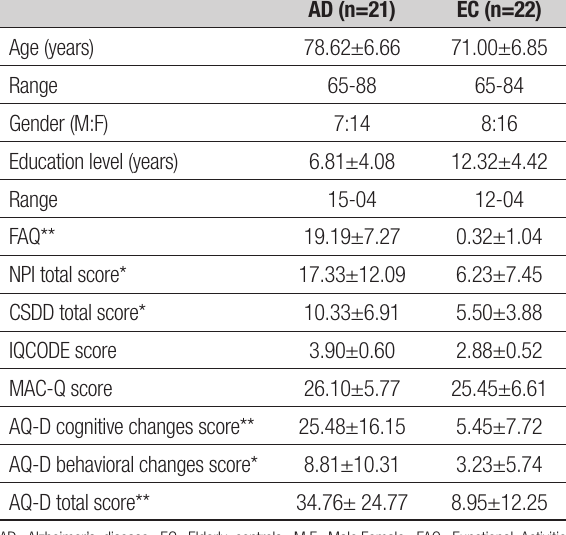
Table 1. Demographic characteristics in AD patients and elderly